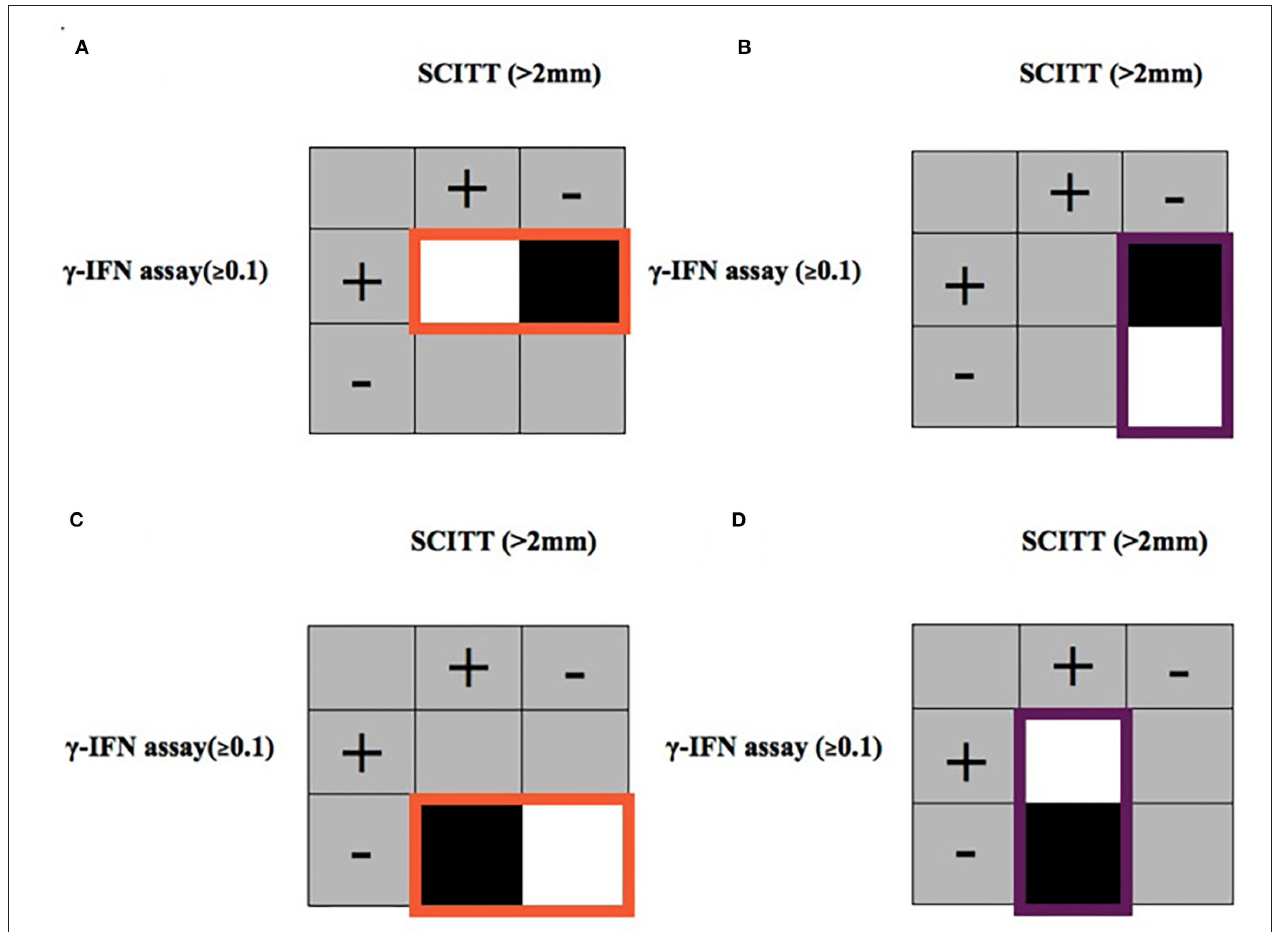
FIGURE 2 | Diagrammatic representation of data subset to investigate two types of test disagreement. 1. IFN- γ assay-positive ( ≥ 0.1) and SCITT-negative ( ≤ 2mm) using models (A,B) . Model (A) Subset of all cattle with a IFN- γ assay-positive response highlighted in orange with SCITT as the dependent variable. Model (B) Subset of all cattle with a SCITT-negative response highlighted in purple with IFN- γ assay as the dependent variable. Black areas indicate “positive” (disparate results) and white areas indicates “negative” (agreeing results) of the dependent variable. 2. IFN- γ assay-negative ( < 0.1) and SCITT-positive ( > 2mm) in pastoral cattle using models (C,D) . Model (C) Subset of all cattle with a IFN- γ assay-negative response highlighted in orange with SCITT as the dependent variable. Model (D) Subset of all cattle with a SCITT-positive response highlighted in purple with IFN- γ assay as the dependent variable. Black areas indicate “positive” (disparate results) and white areas indicates “negative” (agreeing results) of the dependent